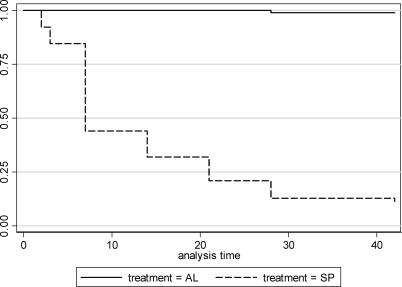
Kaplan-Meier Survival Analysis of Time to Clinical or Parasitological FailureFollowing treatment with SP in 2000 (n = 98) and artemether-lumefantrine in 2001 (n = 100), the proportion of patients with an adequate clinical and parasitological response to treatment at each day of follow up is shown.